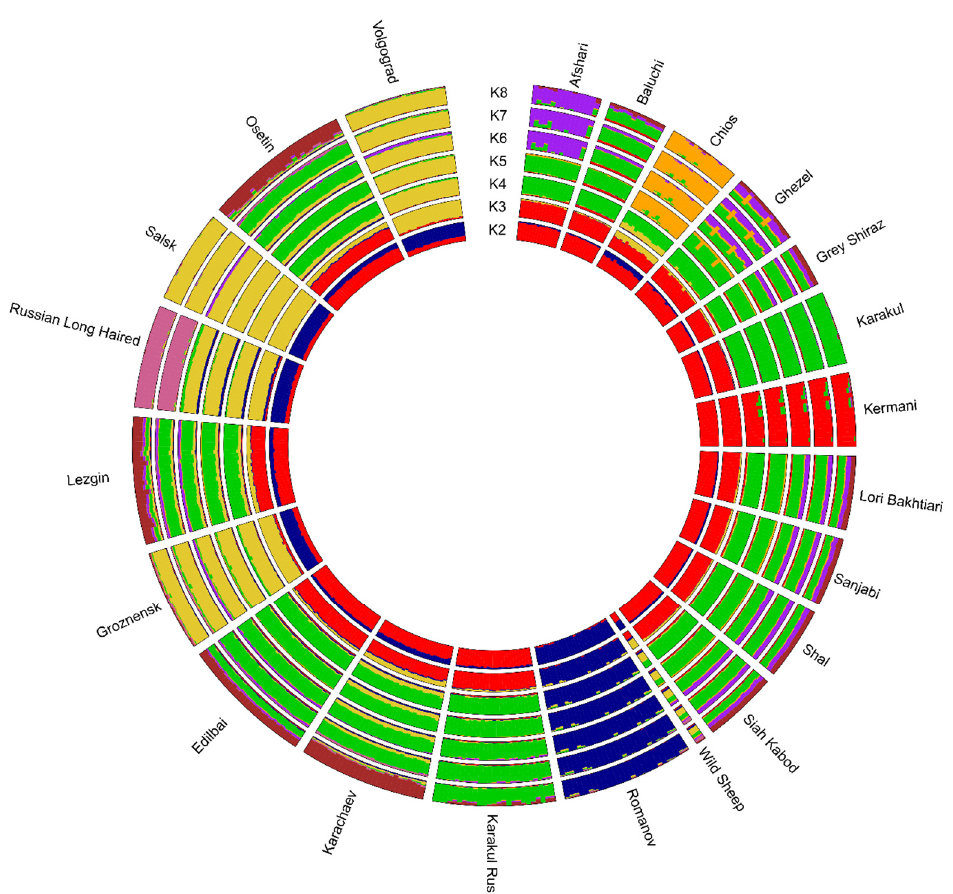
Figure 3. Clustering of Iranian and Russian local sheep breeds.